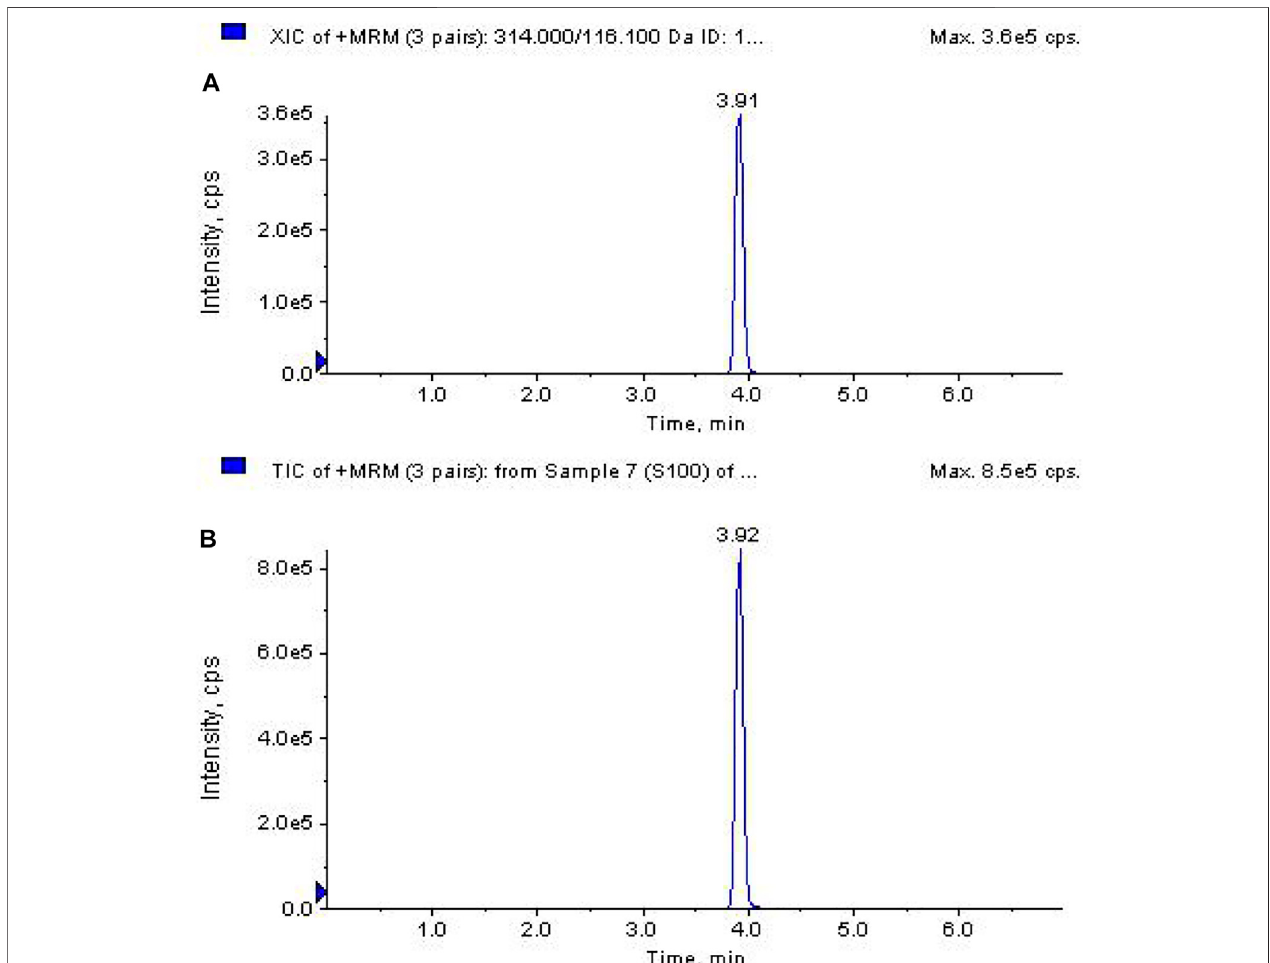
FIGURE 2 | The typical chromatograms of standard kresoxim-methyl at 0.1 mg/L (A) and banana sample spiked with fungicides at 0.1 mg/L (B) .